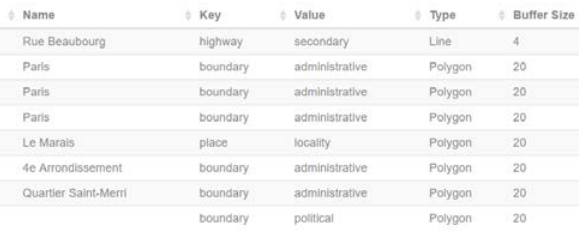
Table 2 List of objects with the new ATM in their buffer zone